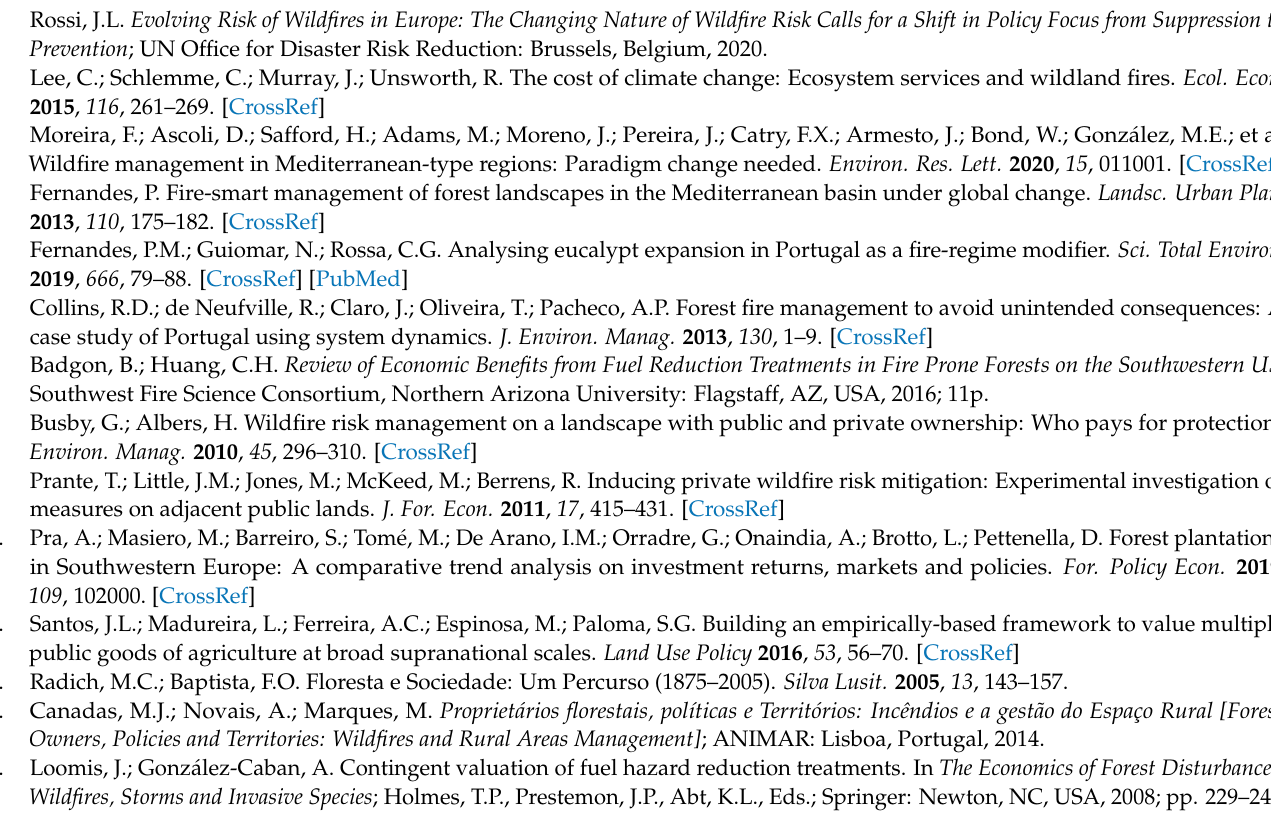
Figure A2. Card 2—visual presentation of the prevention measures (i.e., the choice experiment’s attributes shrub and fuel break) under the contract explained to the respondents.